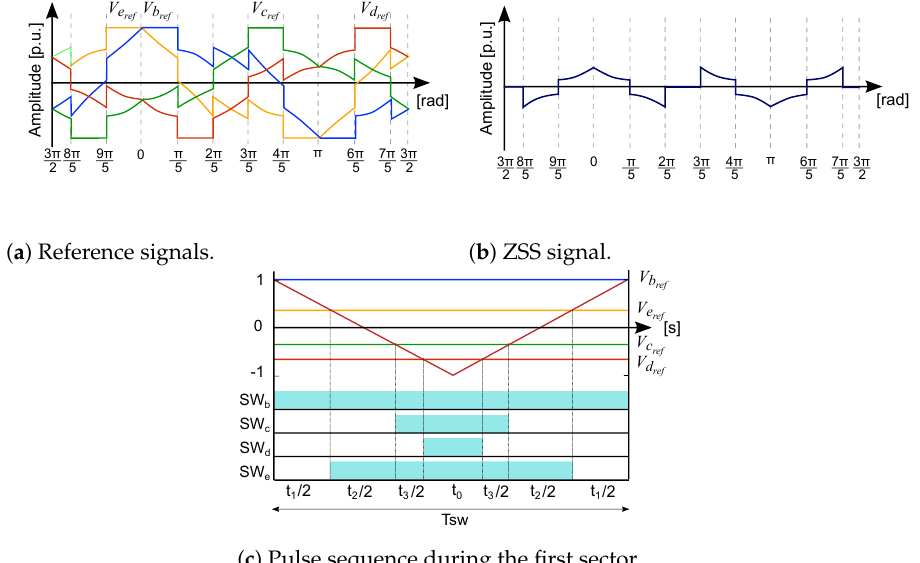
( c ) Pulse sequence during the first sector. Figure 4. HD-PWM